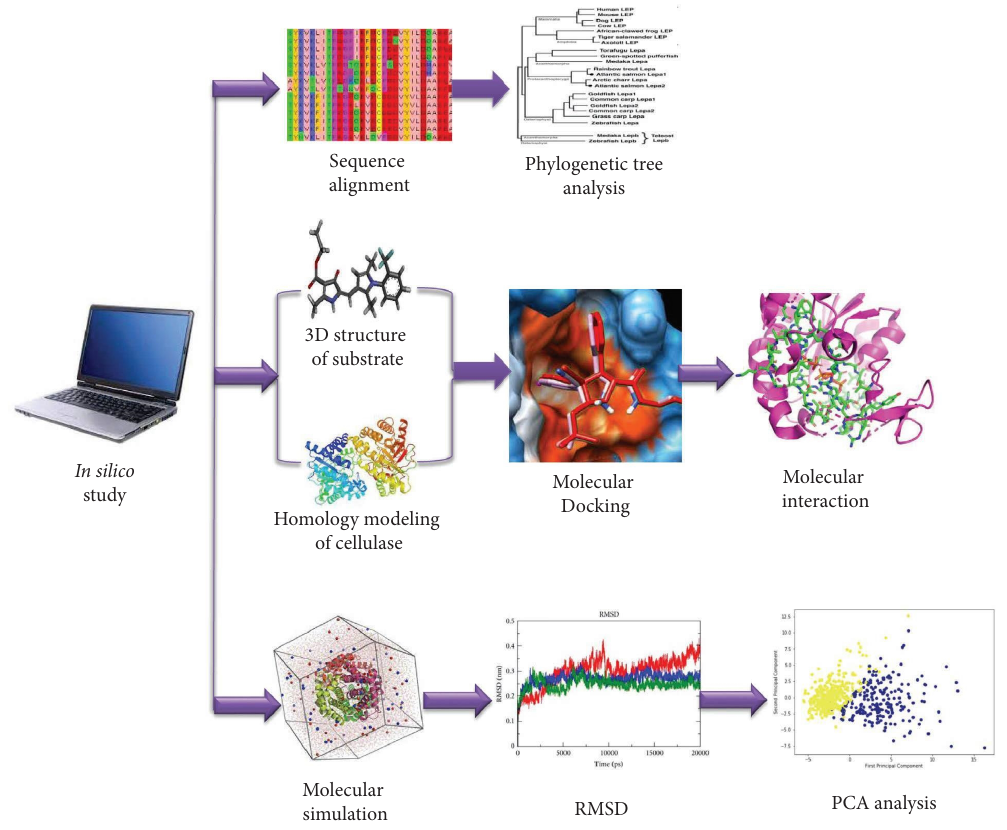
Figure 2: In silico -based study on microbial cellulase enzyme for the understanding of its diferent